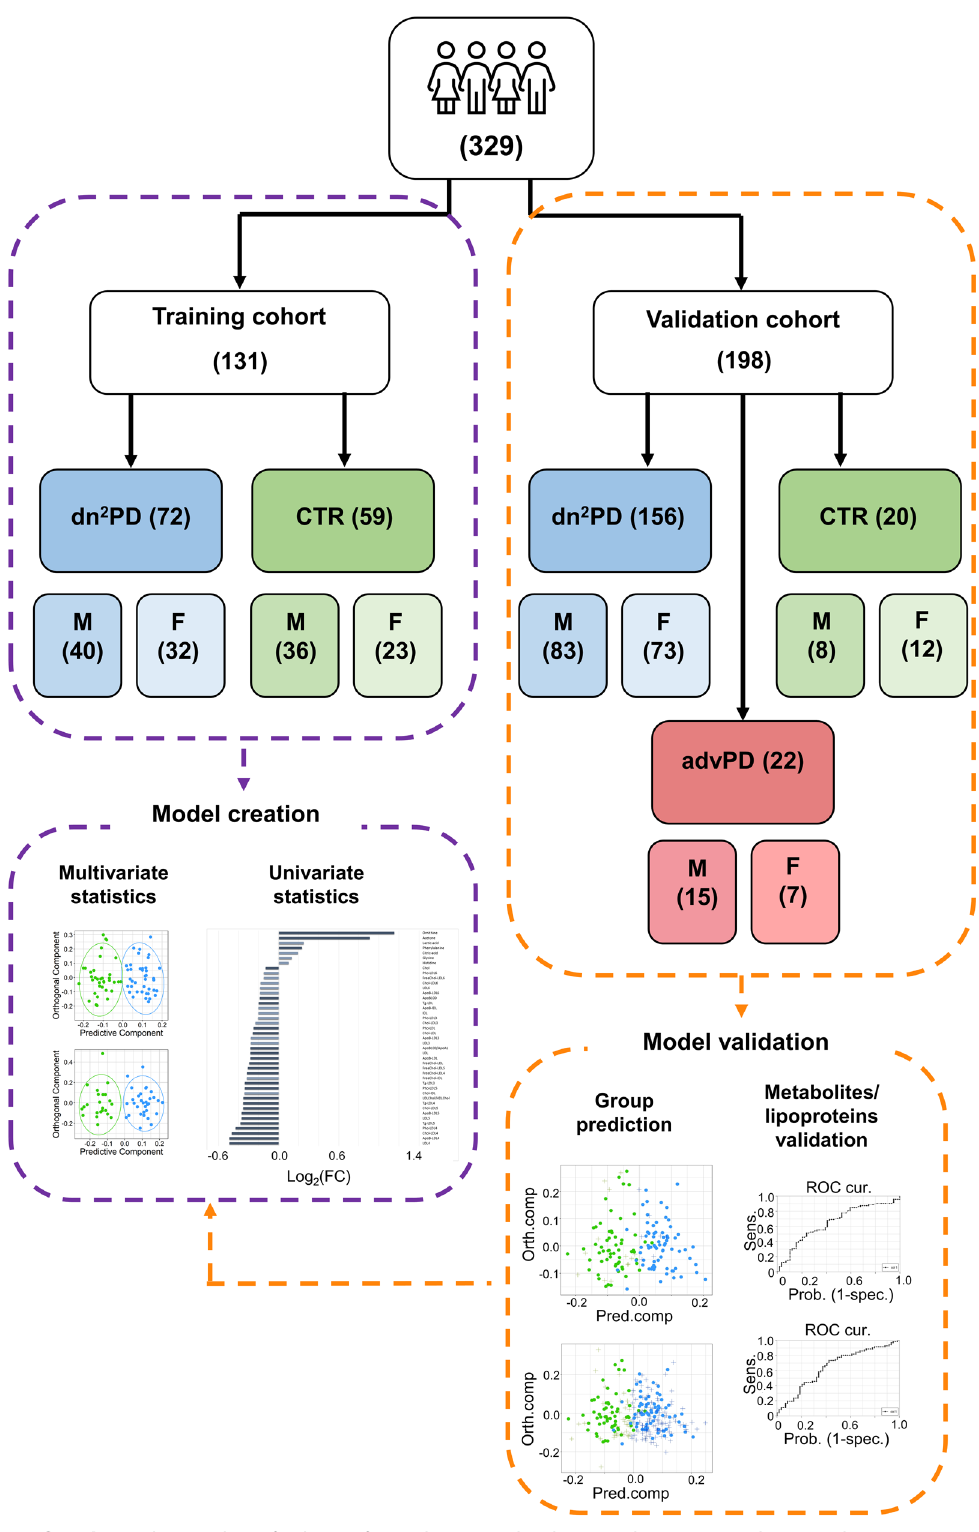
Fig. 1 Study design fl owchart. The number of subjects for each group (the de novo drug-naive Parkinson ’ s disease patients (dn 2 PD), healthy control subjects (CTR), and advanced Parkinson ’ s disease under dopaminergic treatment (advPD)) is reported. The number of male (M) and female (F) subjects for each group are also